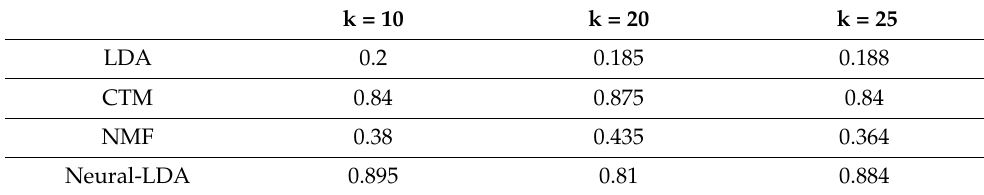
Table 4. Topic Diversity